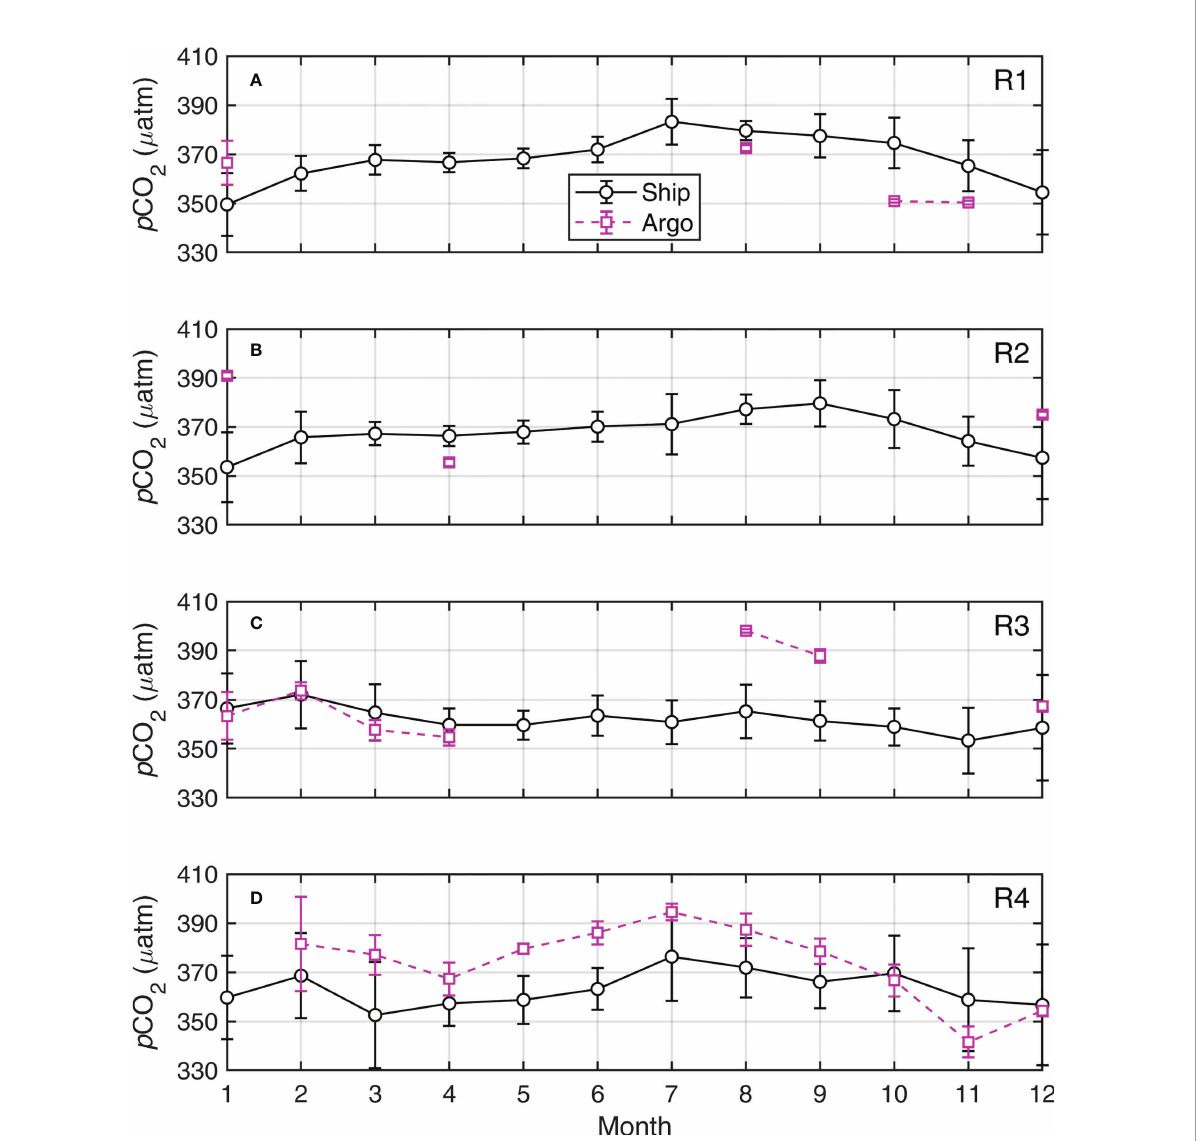
FIGURE 5 The comparison between ship-based and fl oat-based monthly p CO 2 in each region (A – D) of the Drake